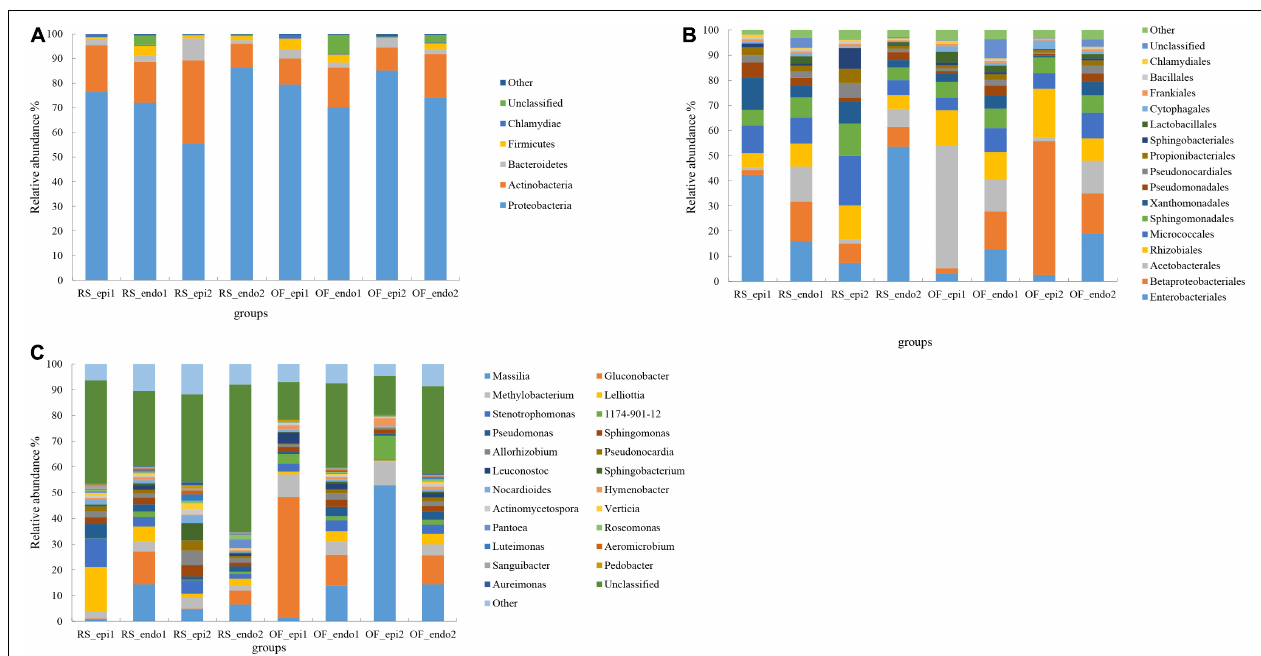
FIGURE 1 | Relative abundance of bacterial taxa at the level of phylum (A) , order (B) , and genus (C) . Bacterial taxa with a relative abundance < 1% were grouped together and are designated as “Other.” Samples labeled "RS" and "OF" designate rain-shelter (RS) and open-field (OF) samples, respectively. The terms "epi" and "endo" designate epiphytic and endophytic sample groups, respectively, and the designations "1" and "2" indicate “Hongyang” and “Cuiyu” cultivars, respectively. The samples were taken in September